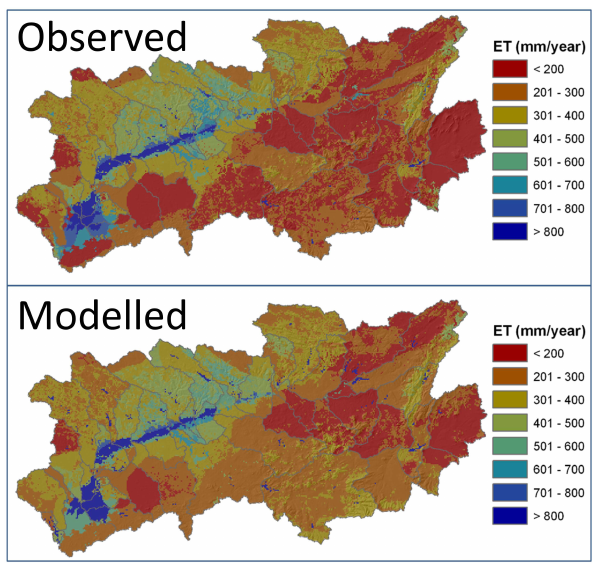
Fig. 8. Observed (top) and modelled (bottom) actual evapotranspi- ration from October 2004 to September 2005 at HRU level.